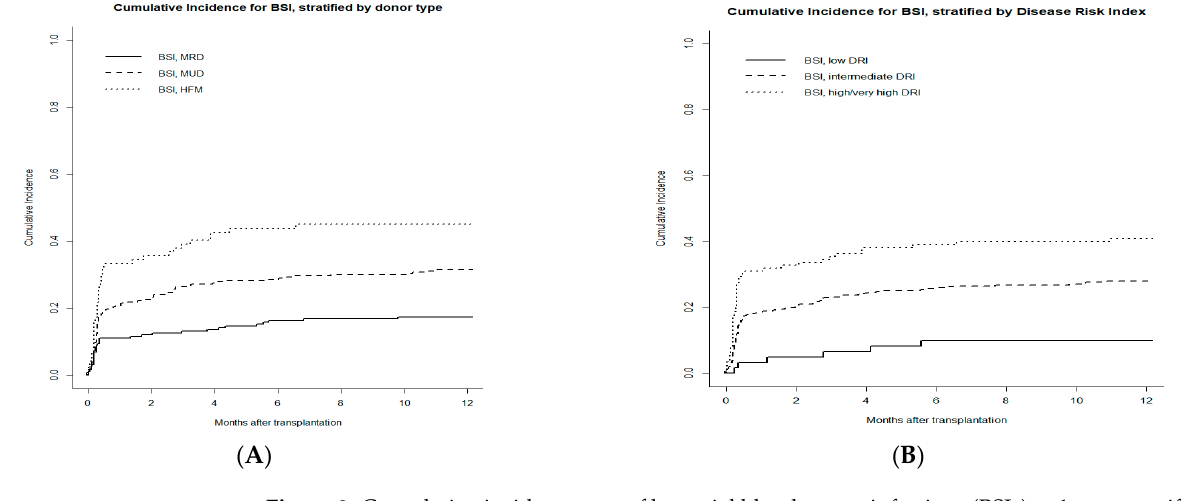
Figure 2. Cumulative incidence rate of bacterial bloodstream infections (BSIs) at 1 year stratified for: ( A ) donor type and ( B ) DRI. Death or relapse without BSIs is considered the competing event.